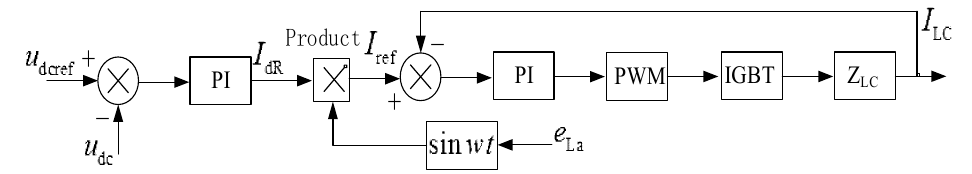
Figure 6. PV charging control strategy diagram.